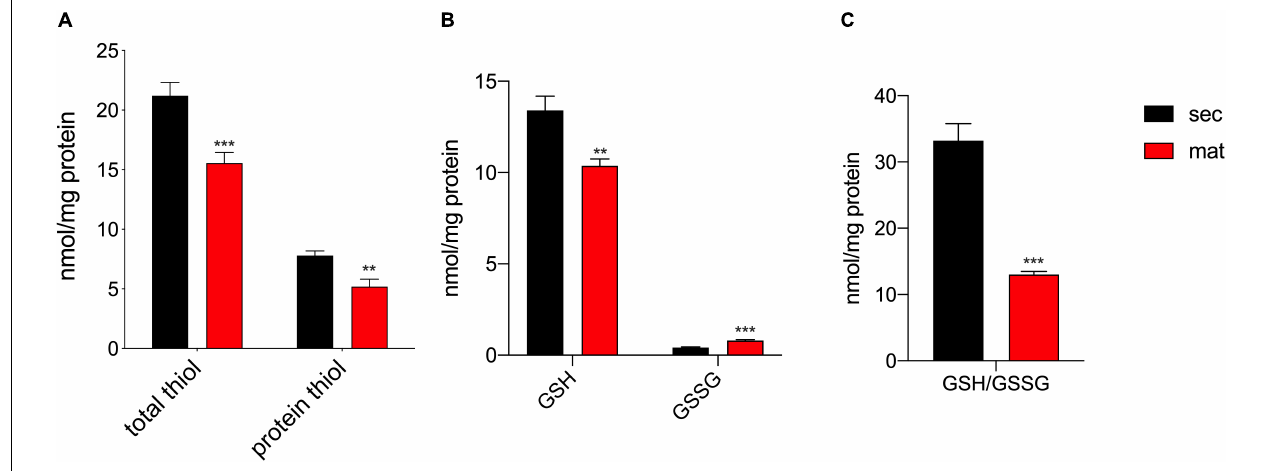
FIGURE 3 | Maturation EO cells show increased oxidation. (A) Maturation stage EO cells show decreased total thiol and thiol protein levels, (B) decreased GSH and increased GSSG. (C) The GSH/GSSG ratio is significantly lower in maturation, indicating increased oxidation. Data represent mean ± SEM from at least n = 3–6 (* P < 0.05, ** P < 0.005, *** P < 0.001, two tailed unpaired Student’s t-